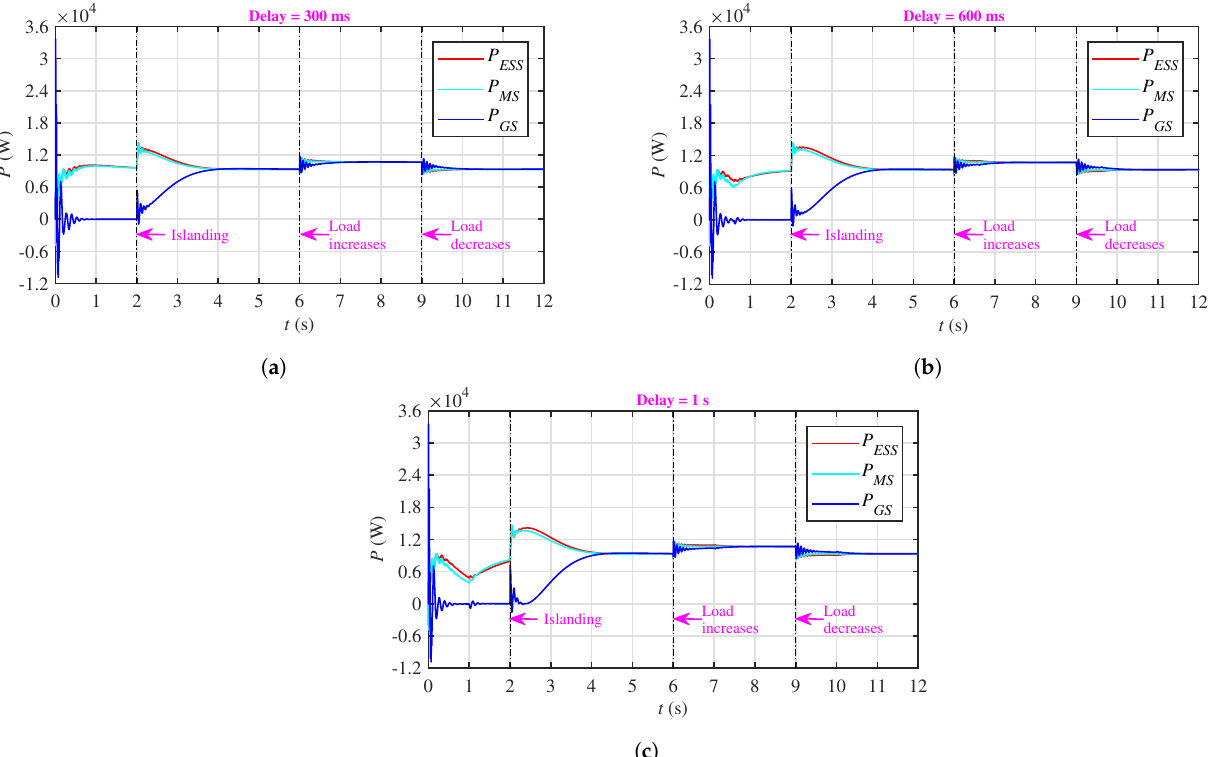
Figure 10. Power sharing outputs of DG units under different communication latencies: ( a ) 300ms ( b ) 600ms, and ( c ) 1s.